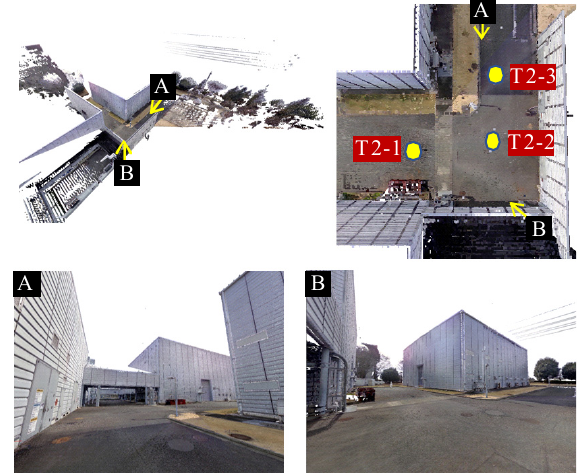
Figure 5. Point clouds of Dataset